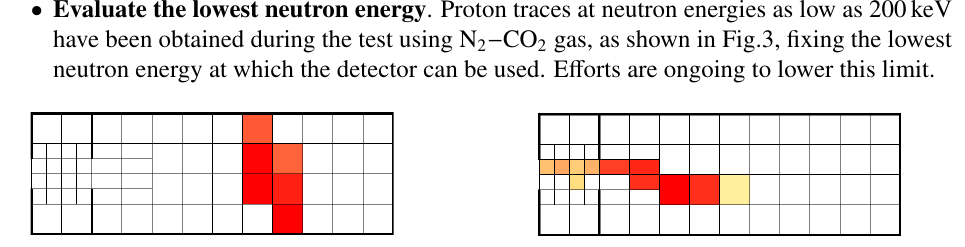
Figure 3. Trajectory reconstruction of a cosmic ray event (left) and of a proton scattered by a 300keV